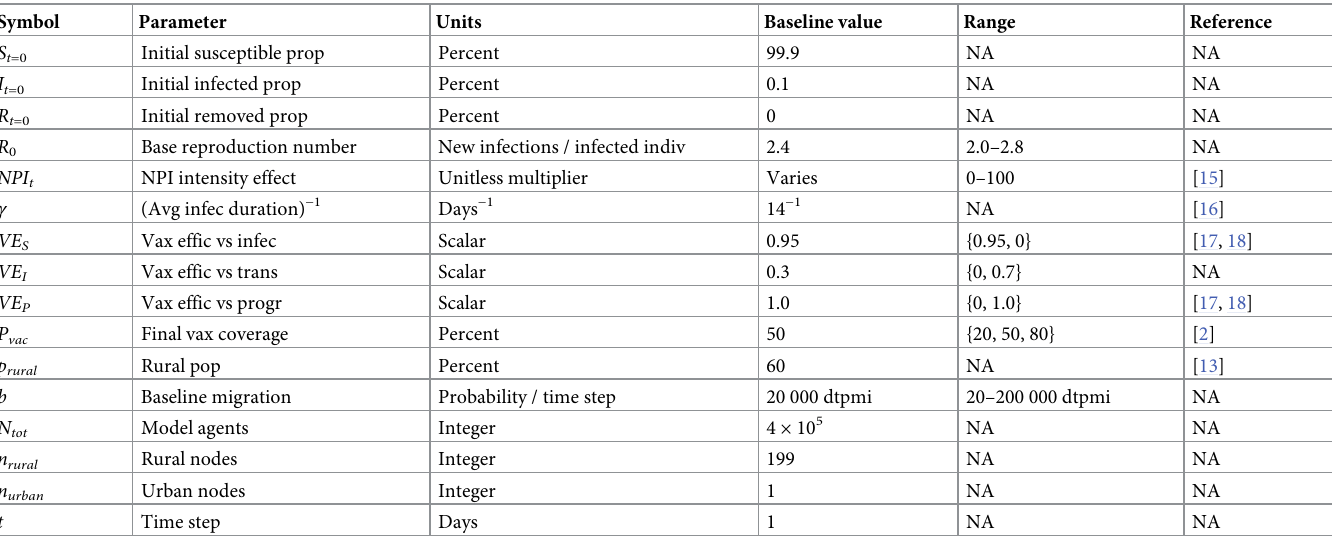
Table 1. Model parameters.